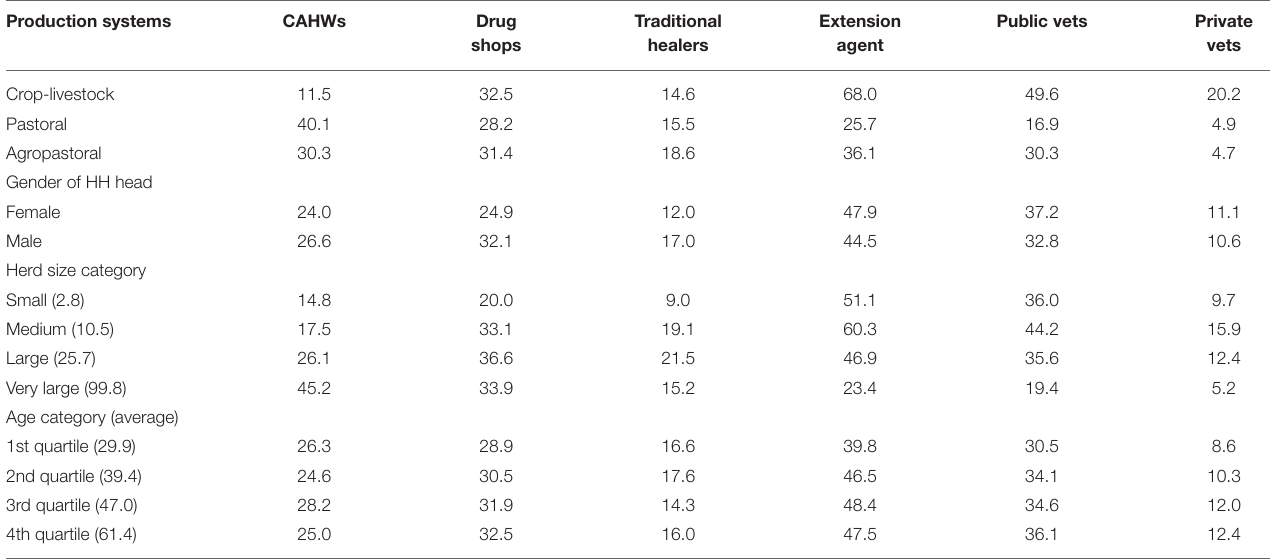
TABLE 6 | Proportion (%) of male and female respondents with different age groups and herd sizes in different production systems reporting access to animal health services by different service providers in eight regions of Ethiopia. Production systems CAHWs Drug